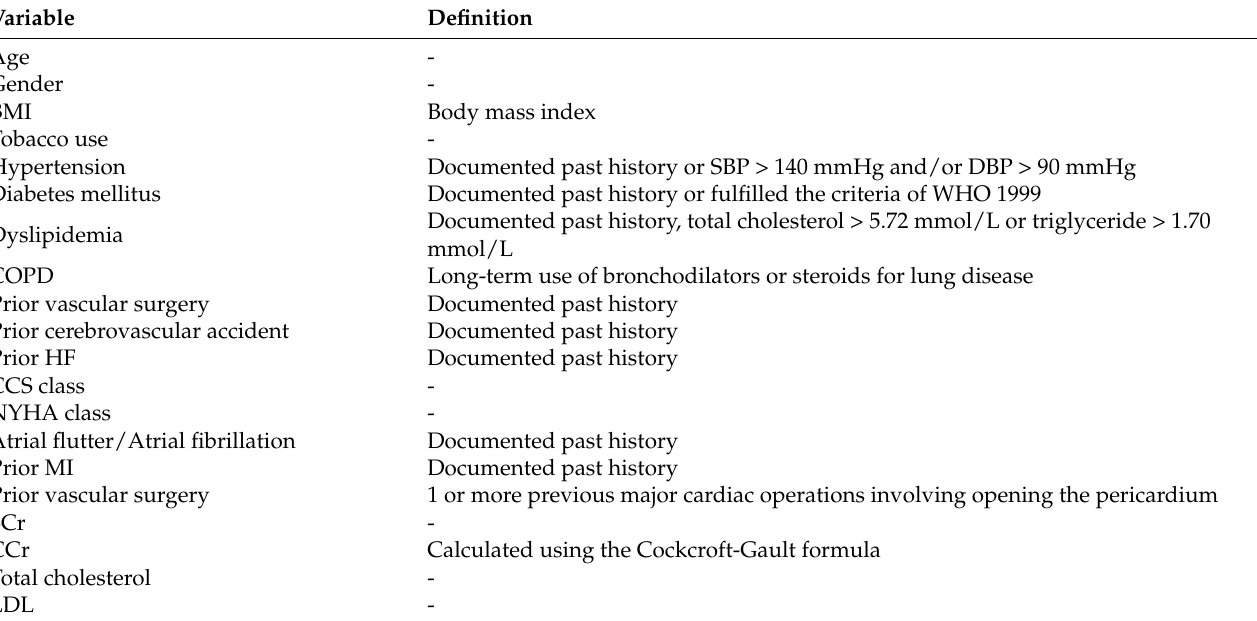
Table 1. Definitions of risk factors for univariate analysis.